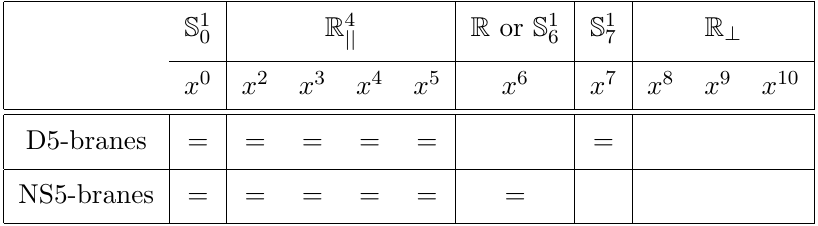
Table 5 . Con(cid:12)guration of intersecting D5- and